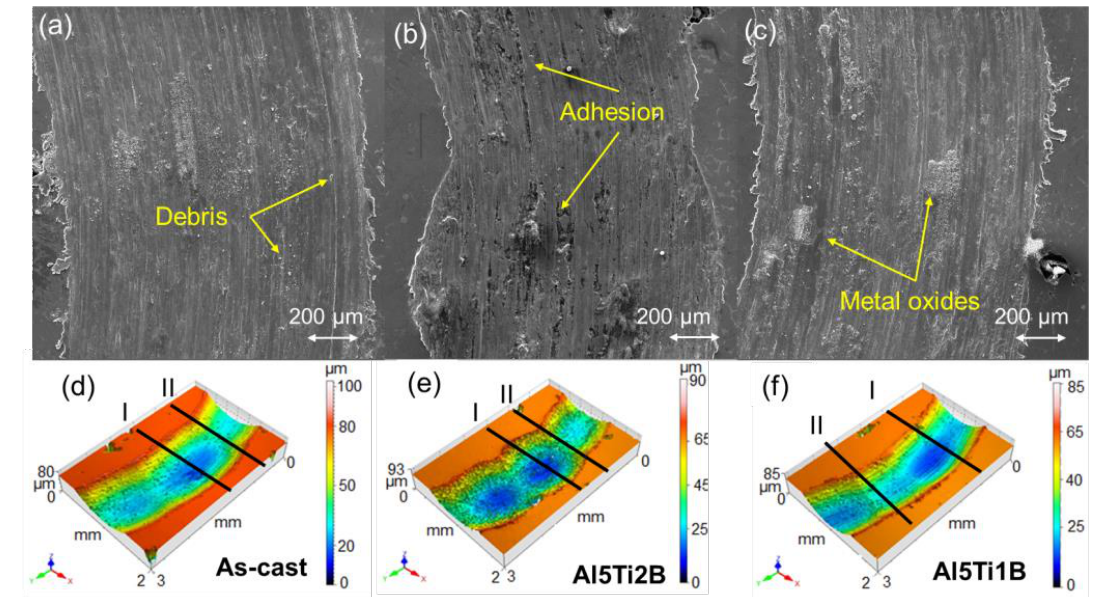
Figure 10. SEM images of wear track after the ball-on-disk testing from ( a ) as-cast; ( b ) Al5Ti2B; ( c ) Al5Ti2B 3D profiles obtained by OP images from ( d ) as-cast; ( e ) Al5Ti2B; ( f ) Al5Ti2B showing the spots of deep [I] and shallow regions [II] take in wear track from the 2D profile.